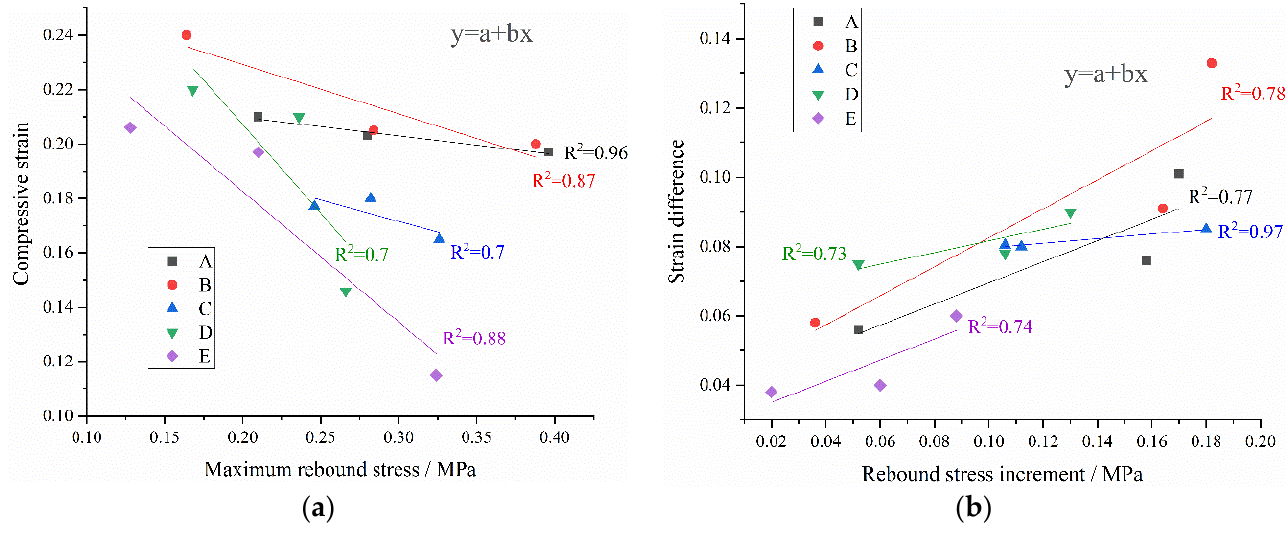
Figure 9. Post-peak deformation parameters: ( a ) maximum rebound stress and compressive strain; ( b ) rebound stress increment and strain